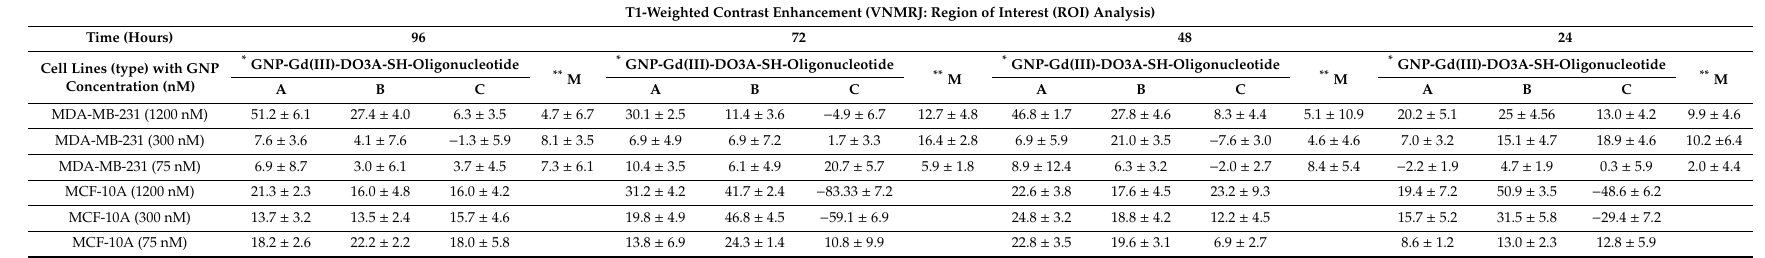
Table 3. T1-Weighted contrast enhancement comparison for GNP-Gd(III)-DO3A-SH oligonucleotide in MDA-MB-231 & MCF-10A cell lines using 2D region of interest analysis ( n = 5) in VNMRJ software.